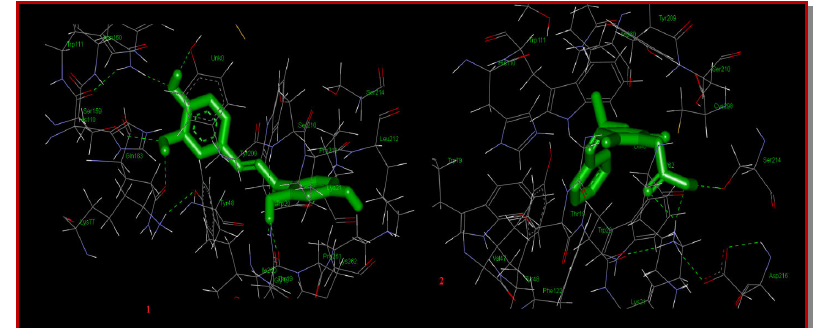
Figure 3: Docked pose of aldose reductase enzyme (3EL3) with butein and